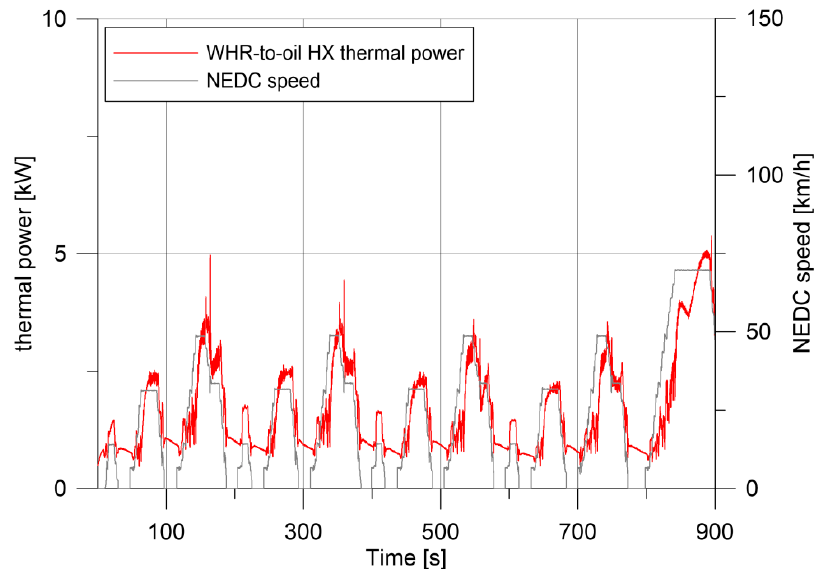
Figure 9. Thermal power exchanged in the WHR-to-oil heat exchanger.